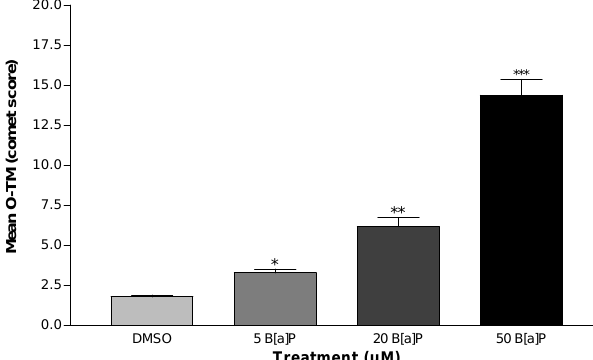
Figure 4 : Comet assay analysis of DNA strand breaks in DU145 prostate carcinoma cell line after 48 hours treatment with B[a]P. The Comet assay analysis demonstrates that the degree of DNA damage by B[a]P was concentration dependent. At 50 μ M concentration the mean olive tail moment was 14. The symbol (*) indicates that the olive tail moment was statistically different from the control. The symbol (**) indicates that the olive tail moment was statistically different from at 5 μ M of B[a]P. The symbol (***) indicates that the olive tail moment was statistically different from 20 μ M concentration of B[a]P a significance of p<0.05.